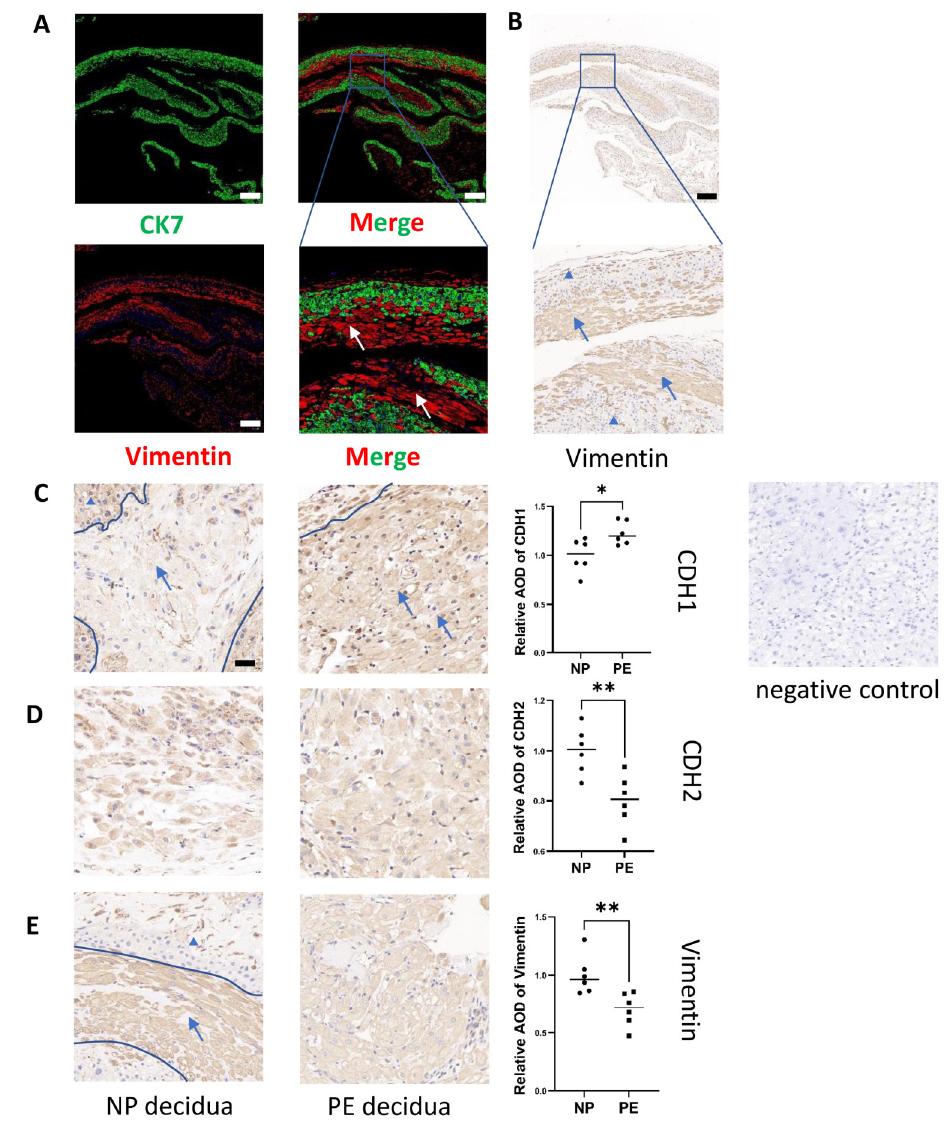
Figure 3. Excess epithelial pattern in DSCs in PE patients. ( A , B ) Immunofluorescence and immunohistochemical staining identified DSCs in decidual tissues. Red: vimentin; Green: CK7, scale bar = 500 nm. The experiment was repeated 3 times independently. ( C , D , E ) Measurement of CDH1, CDH2 and vimentin protein expression in DSCs from women with NP and PE by immunohistochemical staining. The area of DSCs is labelled by arrows and non-DSCs are labelled with triangles, Scale bar = 20 nm. Values are the mean ± SD. * p < 0.05; ** p < 0.01; ns, not significant. n = 6 each. PE: preeclampsia; NP: normal pregnancy; DSC: decidual stromal cell.